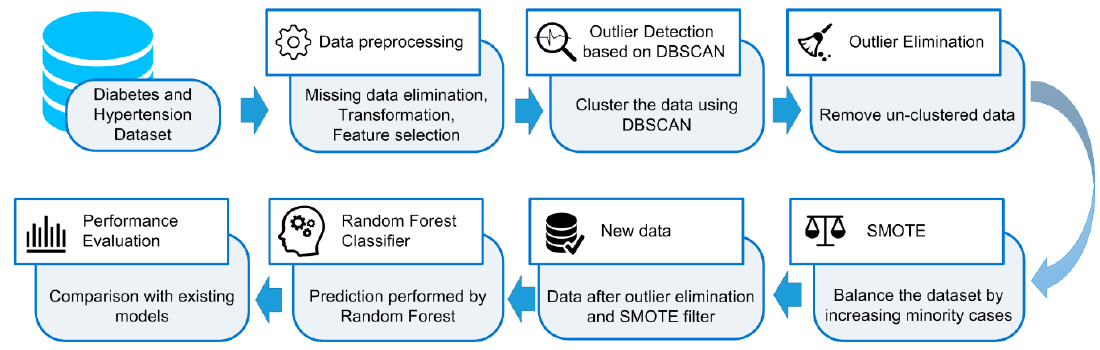
Figure 1. Hybrid Prediction Model (HPM) for type 2 diabetes (T2D) and Hypertension.